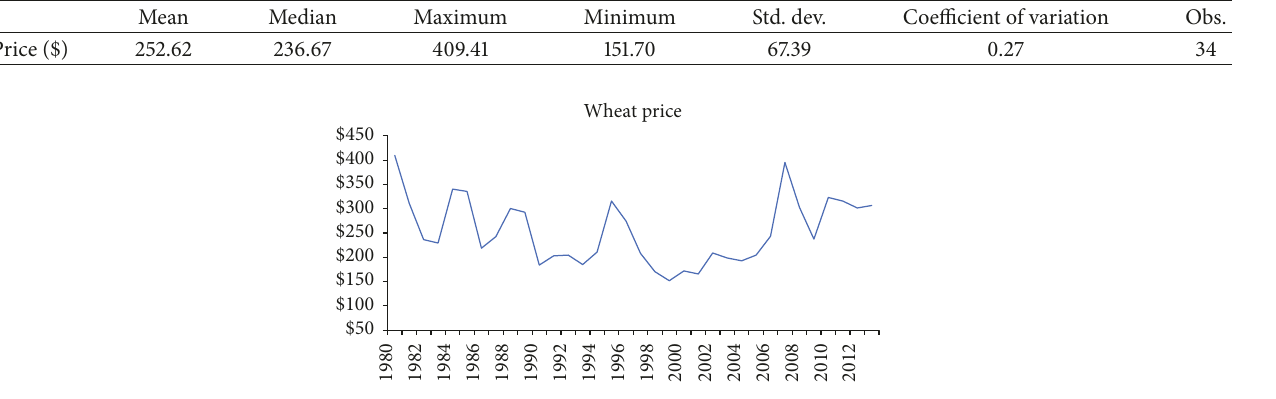
Figure 2: Annual world wheat price, deflated to 2013 dollars. Source : FAO, 2015